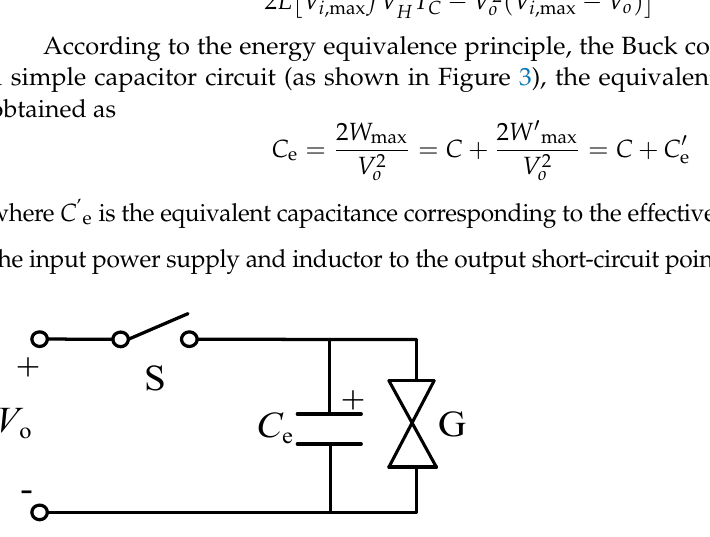
Figure 3. Equivalent simple capacitor circuit. From Figure 3, S is the equivalent switch of a simple capacitor circuit. When the two electrodes of G are disconnected and S is closed, C e is charged. When the two electrodes of G are closed and S is disconnected, C e is